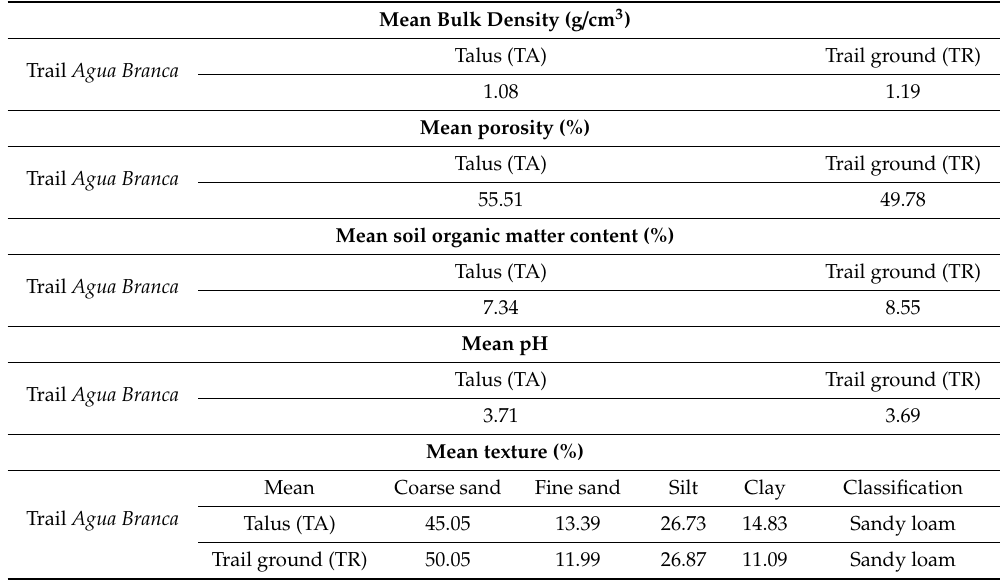
Table 2. Soil properties on trails in Serra do Mar State Park. Coarse sand (2.0–0.2 mm), fine